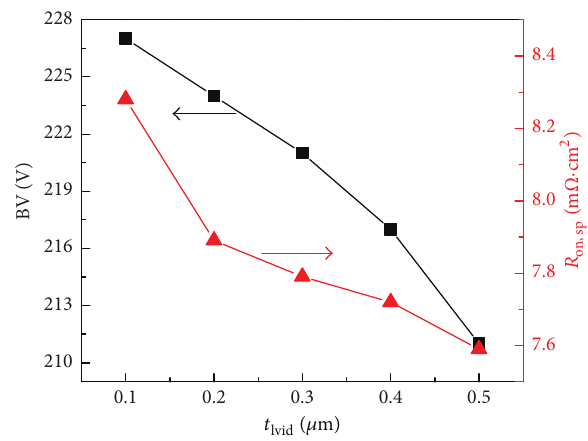
Figure 8: The influences of 𝑡